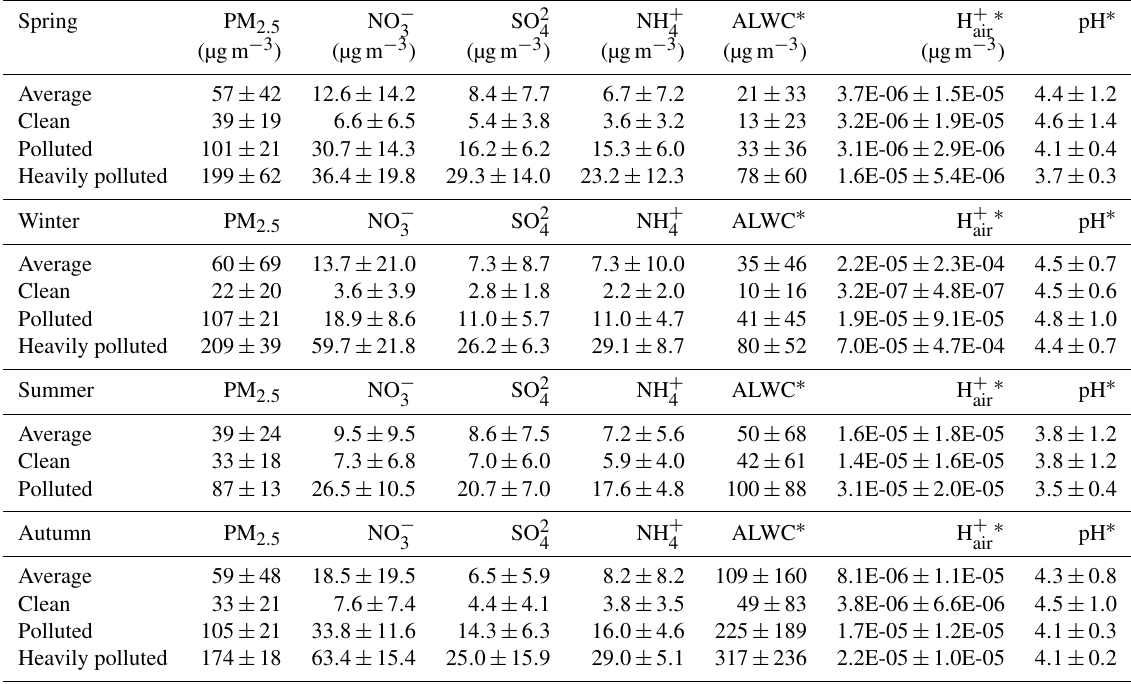
Table 1. Average mass concentrations of NO − heavily polluted conditions over four